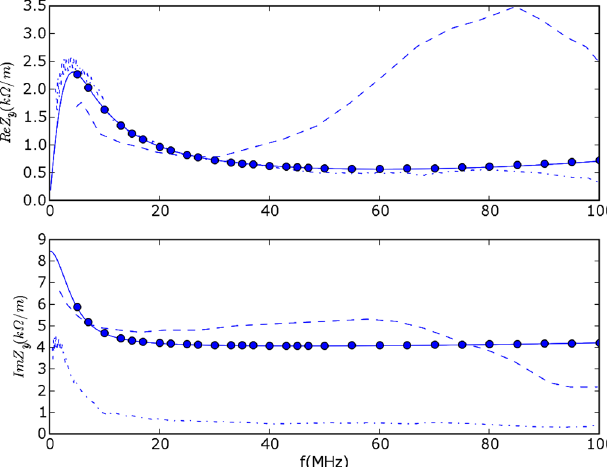
FIG. 6. (Color) Real and imaginary part of Z (cid:6) 25 (cid:2) : direct measurements (dot-dashed line, computed Z g from Z D in [4], Fig. 15), two-wire measurements (dashed line) (cid:1) ! (cid:2) , dots], and prediction from the parame- [3], simulations [ Z sim y (cid:1) ! (cid:2) , solid trization [ Z model y